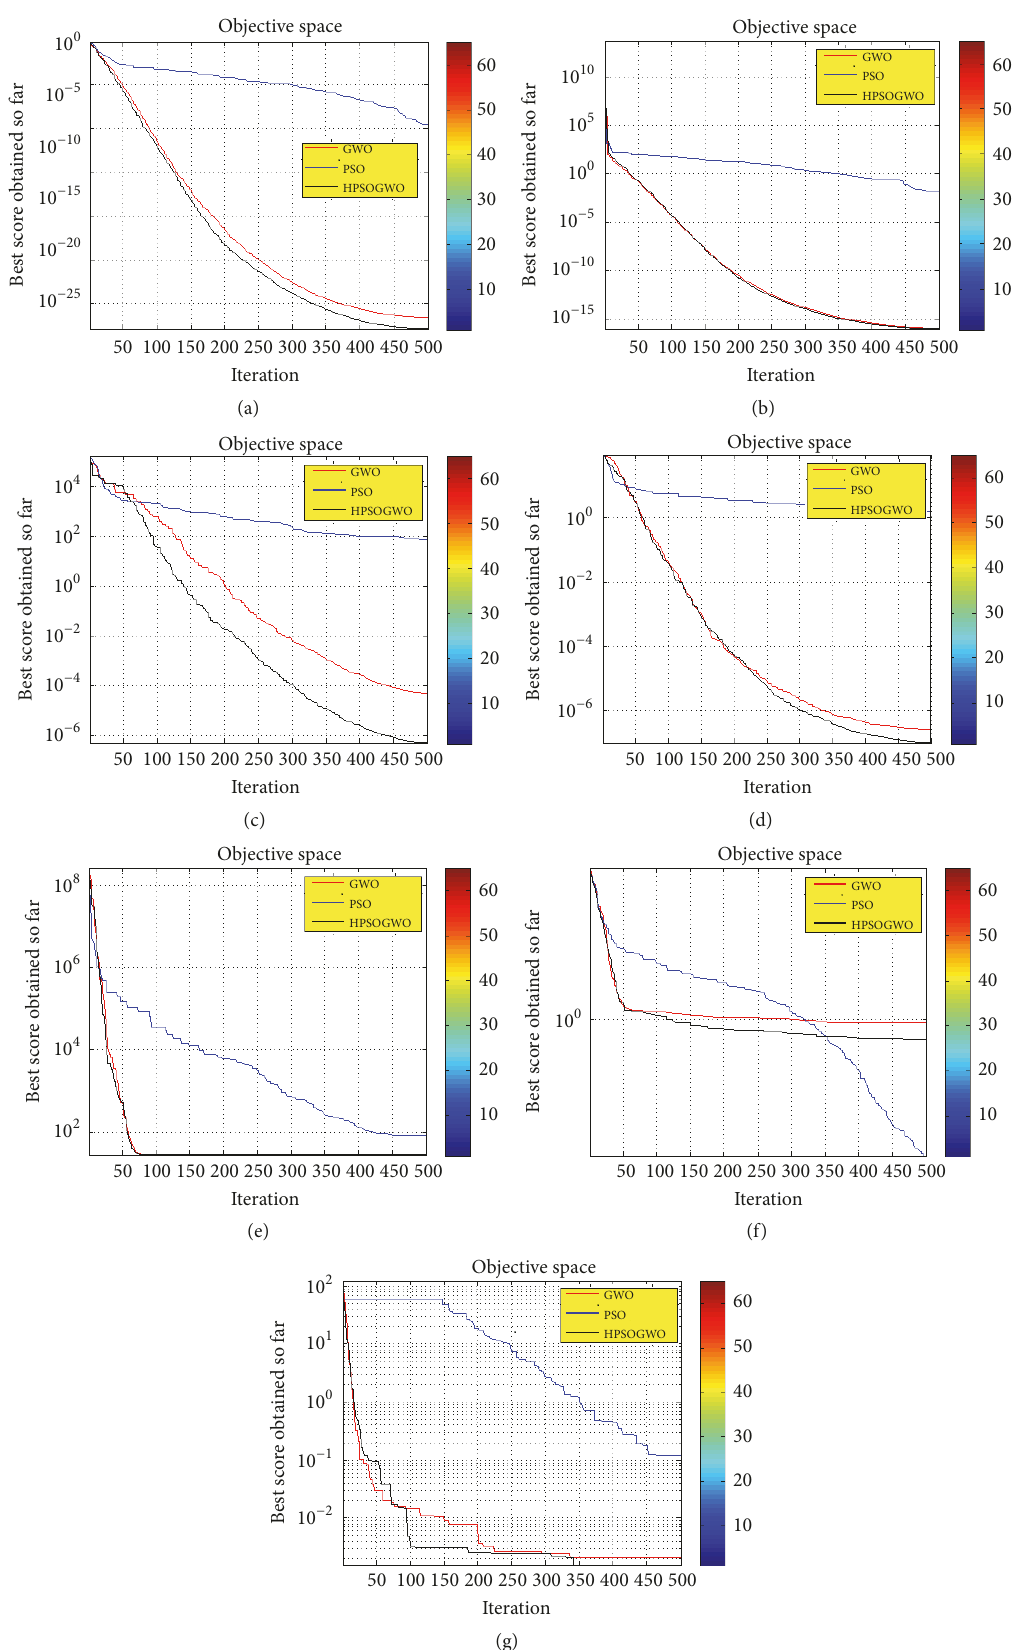
Figure 1: Convergence curve of PSO, GWO, and HPSOGWO variants on unimodal